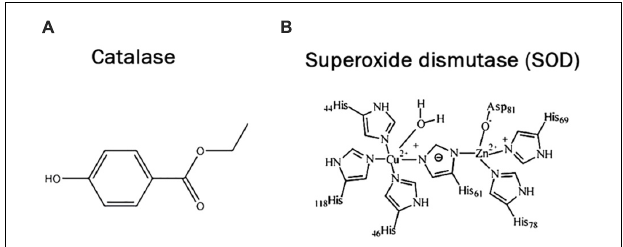
FIGURE 6 | Structural classification of catalase (A) and superoxide dismutase (B) enzymes.